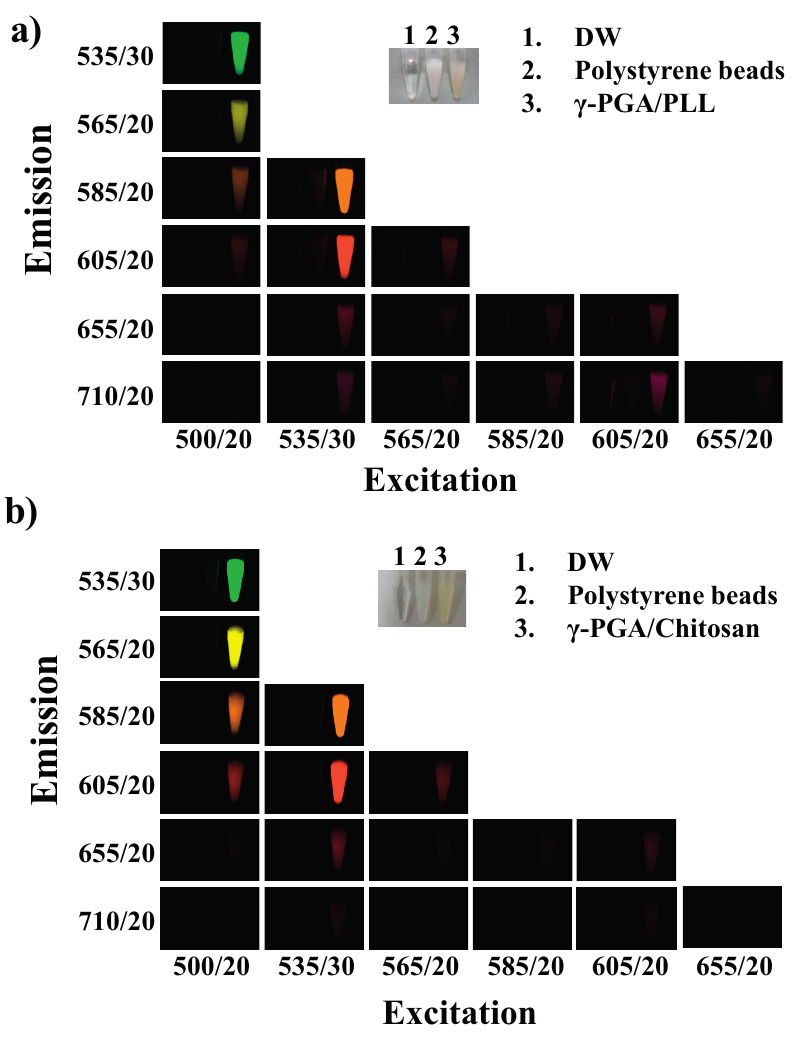
Figure 5. Fluorescence images of ( a ) γ -PGA/PLL cross-linked with glutaraldehyde for 12 h and ( b ) γ -PGA/Chitosan cross-linked with 10 μ L glutaraldehyde for 96 h. (vertical axis: emission wavelength, horizontal axis: excitation wavelength, exposure time: 0.2